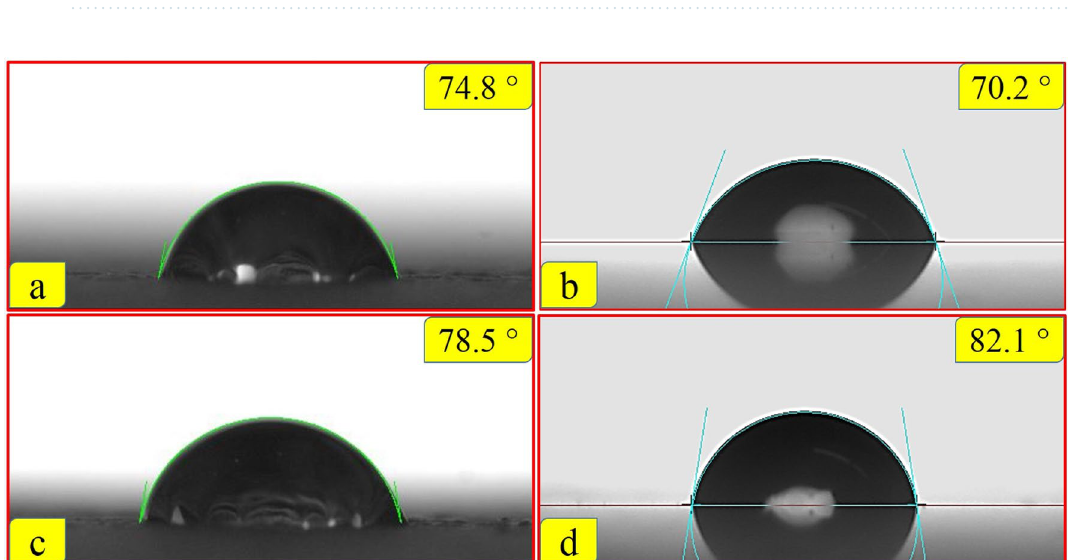
Figure 6. Equivalent circuit models with ( a ) one and ( b ) two time constants employed for analyzing the EIS results.